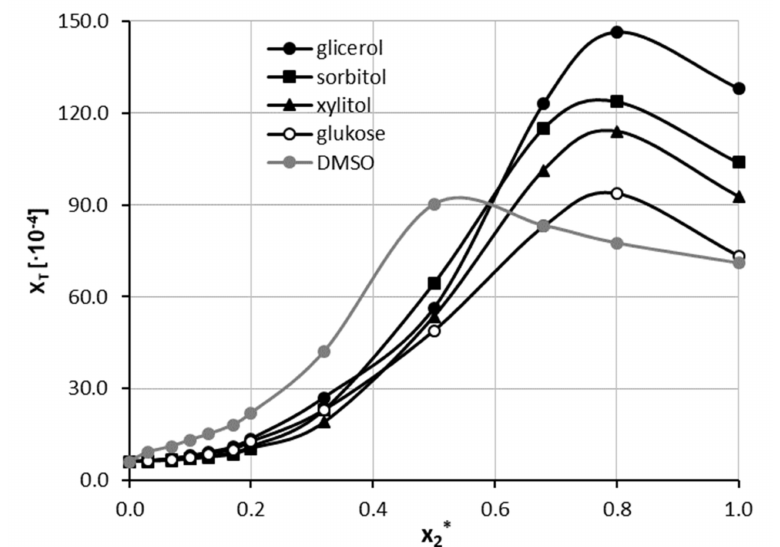
Figure 4. Solubility profiles of theophylline at 25 ◦ C in mixtures comprising NADES successfully diluted with water. On the ordinate, x ∗ , represents values of the mole fractions of Natural Deep NADES Eutectic Solvent in aqueous solutions. For comparison purposes, solubility in DMSO+water was plotted as a function of x ∗ (grey 2